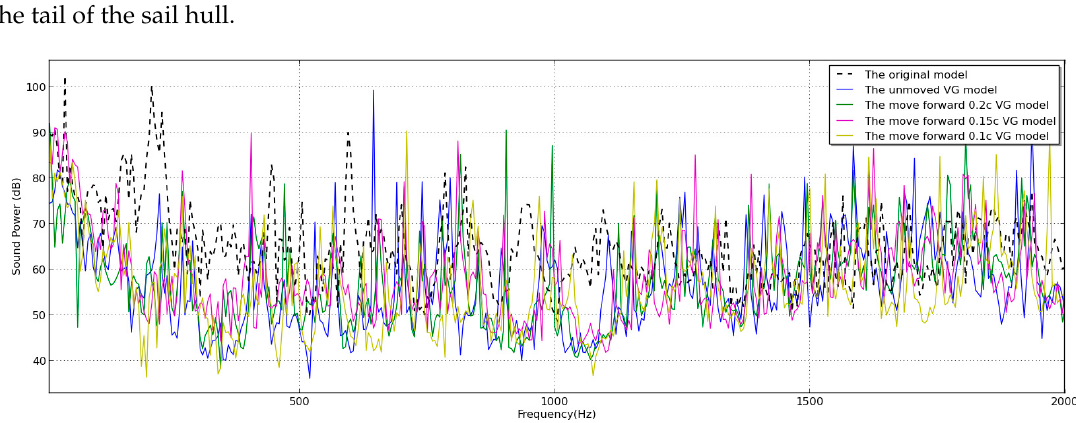
Table 3. The total level of radiated sound power from the different models.